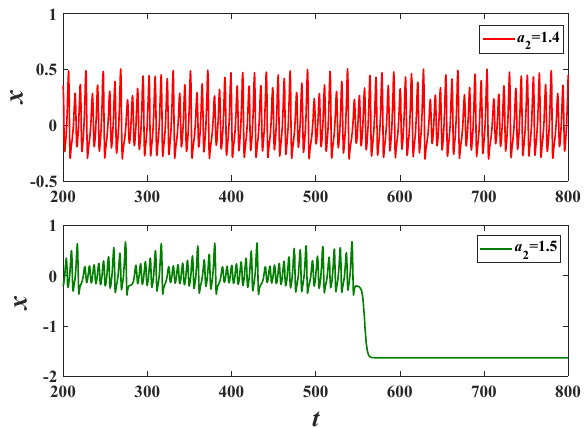
Figure 11. Time ‐ domain waveforms with a 2 = 1.4 (red) and 1.5 (green). Figure 11. Time-domain waveforms with a 2 = 1.4 (red) and 1.5 (green).